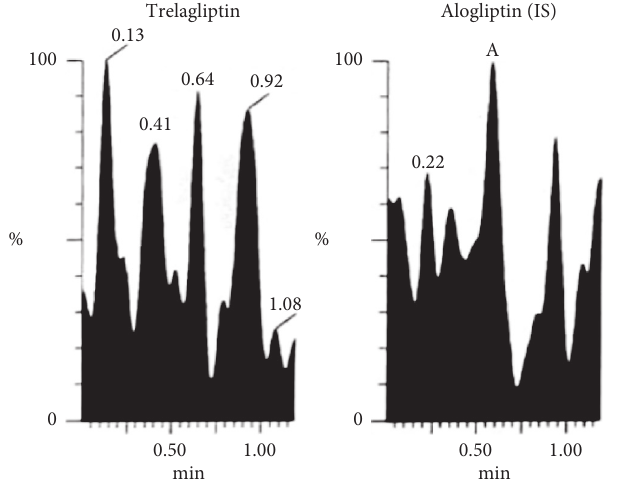
Figure 5: Blank plasma sample (for testing selectivity) showing no interference from endogenous plasma components either with TLN or with IS.